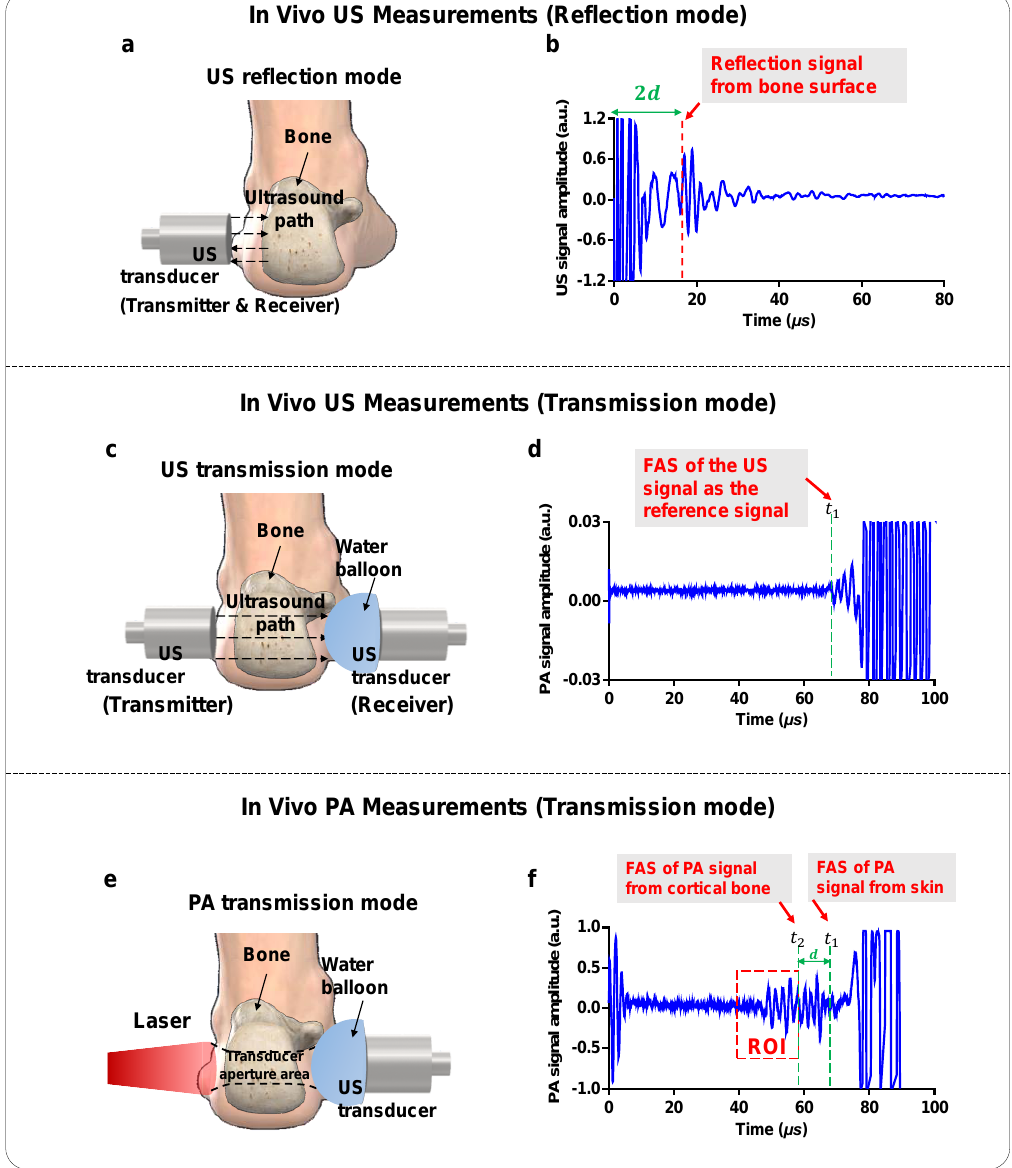
Figure 6. Results of the PA and US in vivo experiments from a human volunteer. ( a ) Schematic diagram of the US-guided system in the reflection mode. ( b ) US signal from bone obtained in vivo using the US transmission mode. ( c ) Schematic diagram of the US system in the transmission mode. ( d ) US signal from bone obtained in vivo using the US transmission mode. ( e ) Schematic diagram of the PA system in the transmission mode. ( f ) PA signal from bone obtained in vivo using the PA transmission mode. The markers had a similar meaning in Figure 5.